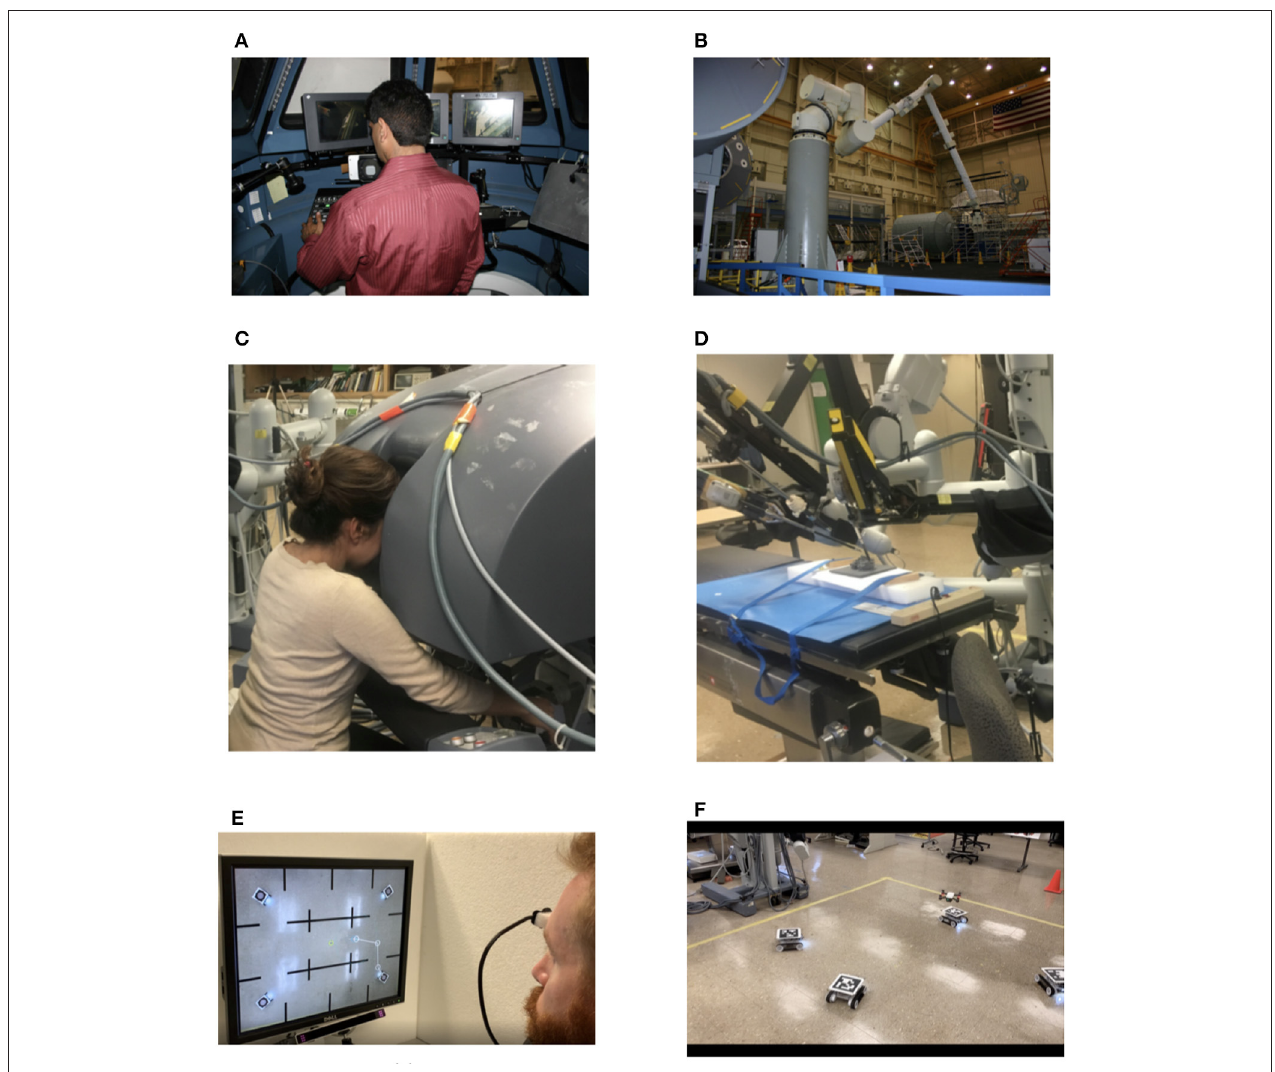
FIGURE 1 | Different applications of teleoperation. (A) Operator of a space robot arm, (B) the space robot arm (Chintamani et al., 2009). (C) Telesurgery with a research da Vinci surgical system (Eslamian et al., 2020), surgeon side. (D) Remote patient side, (E) ground robot control with aerial view (Lucas et al., 2012)— operator controls ground robots using eye-tracking and (F) the ground robots (Lucas et al., 2012).